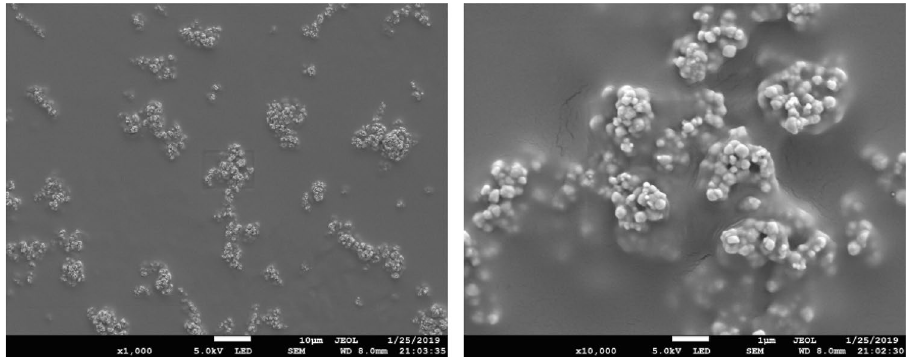
Figure 6. Scanning electron microscope of magnetic beads preset